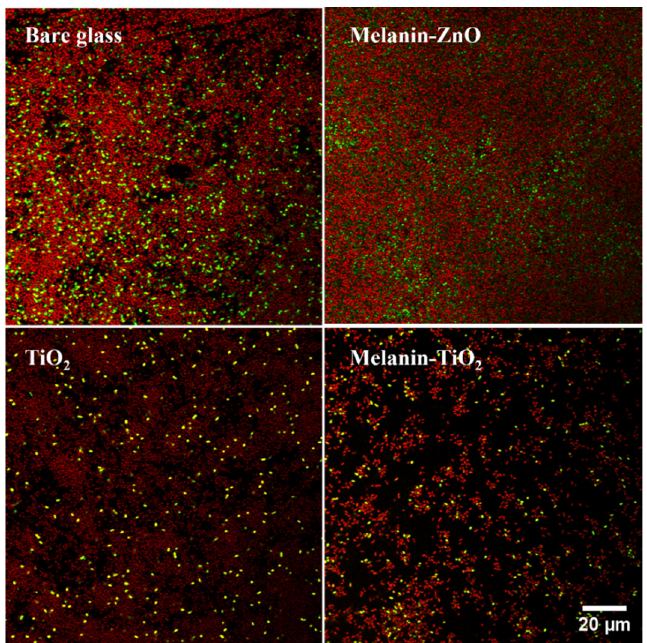
Figure 4. Confocal laser scanning microscopy scans performed with LIVE/DEAD staining of 48 h biofilm growth on bare glass (control) and functionalized samples (nanoparticles of melanin/ZnO, TiO 2 , melanin/TiO 2 ). Live bacteria are reported in green, dead in red.